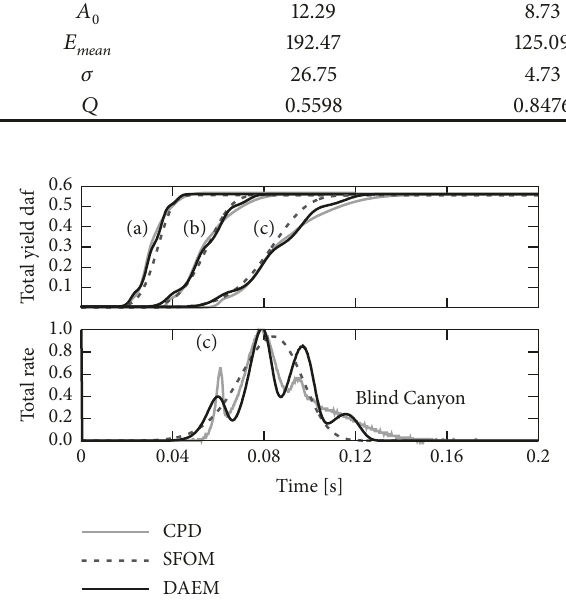
Figure 4: Coal devolatilization. Top: total yield (daf); down: total rate (daf) normalised by the maximum value of the CPD rate. (a) From 300 to 1700 K in 0.06 s, (b) from 300 to 1600 K in 0.1 s, and (c) from 300 to 1500 K in 0.15